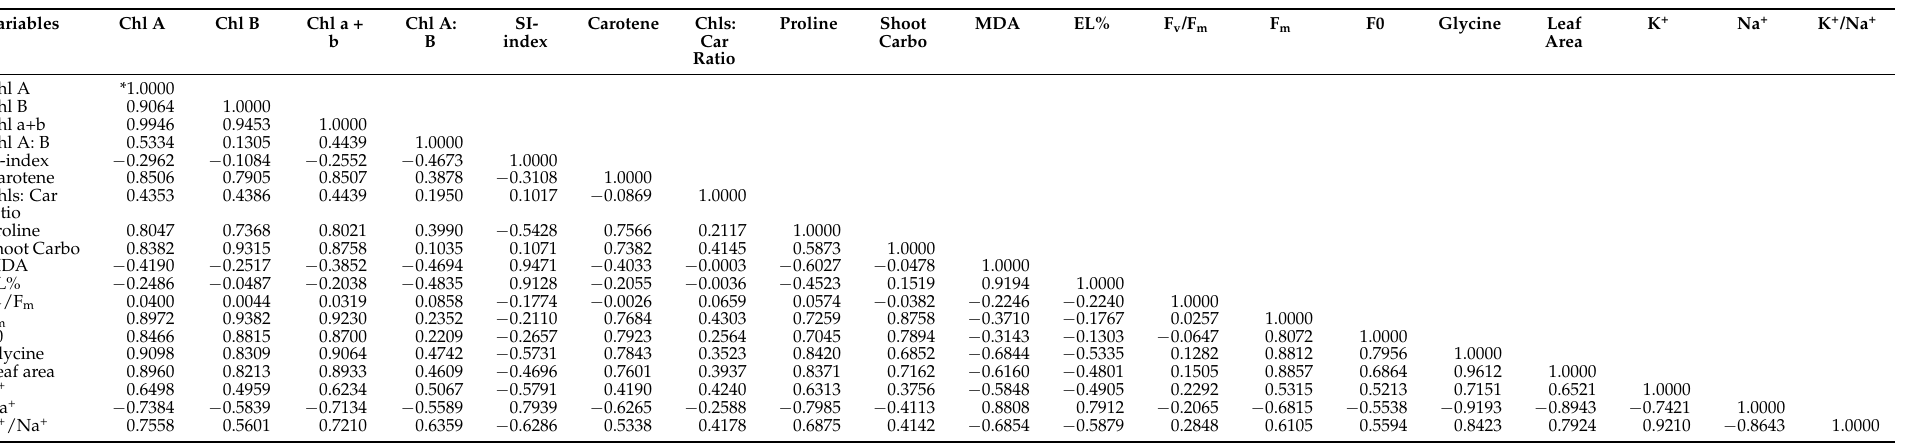
Table 8. Shows the Pearson correlation matrix for the parameters of “superior seedless” vines grown on three